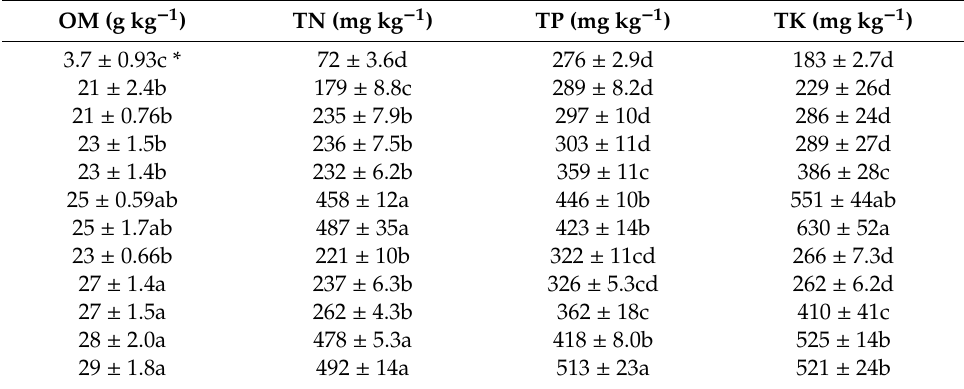
Table 3. Nutrient elements in the mine soil with different amendments (means ± S.E., n = 4). OM (g kg -1 ) TN (mg kg -1 )